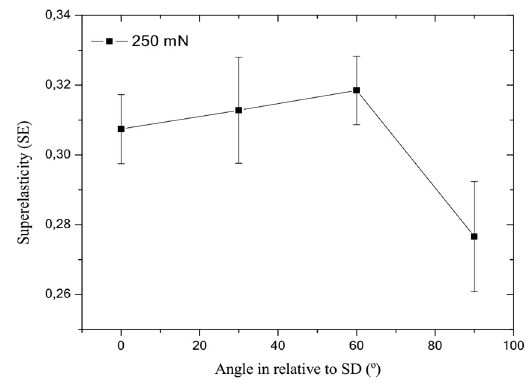
Figure 7. Superelasticity as a function of solidification